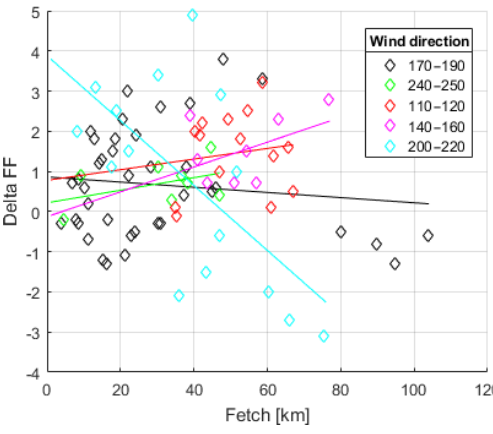
Figure 11. Changes of the wind speed at hub height as in Fig. 10. Different sectors of the wind direction are indicated in different